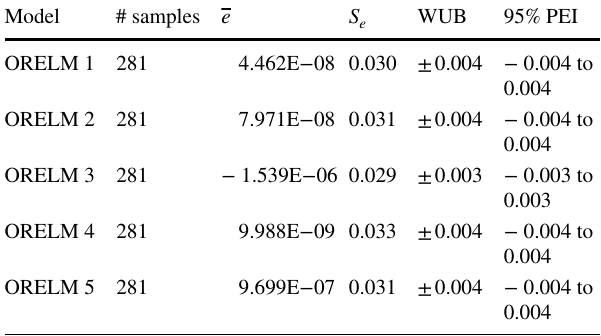
Table 2 UA results for ORELM models